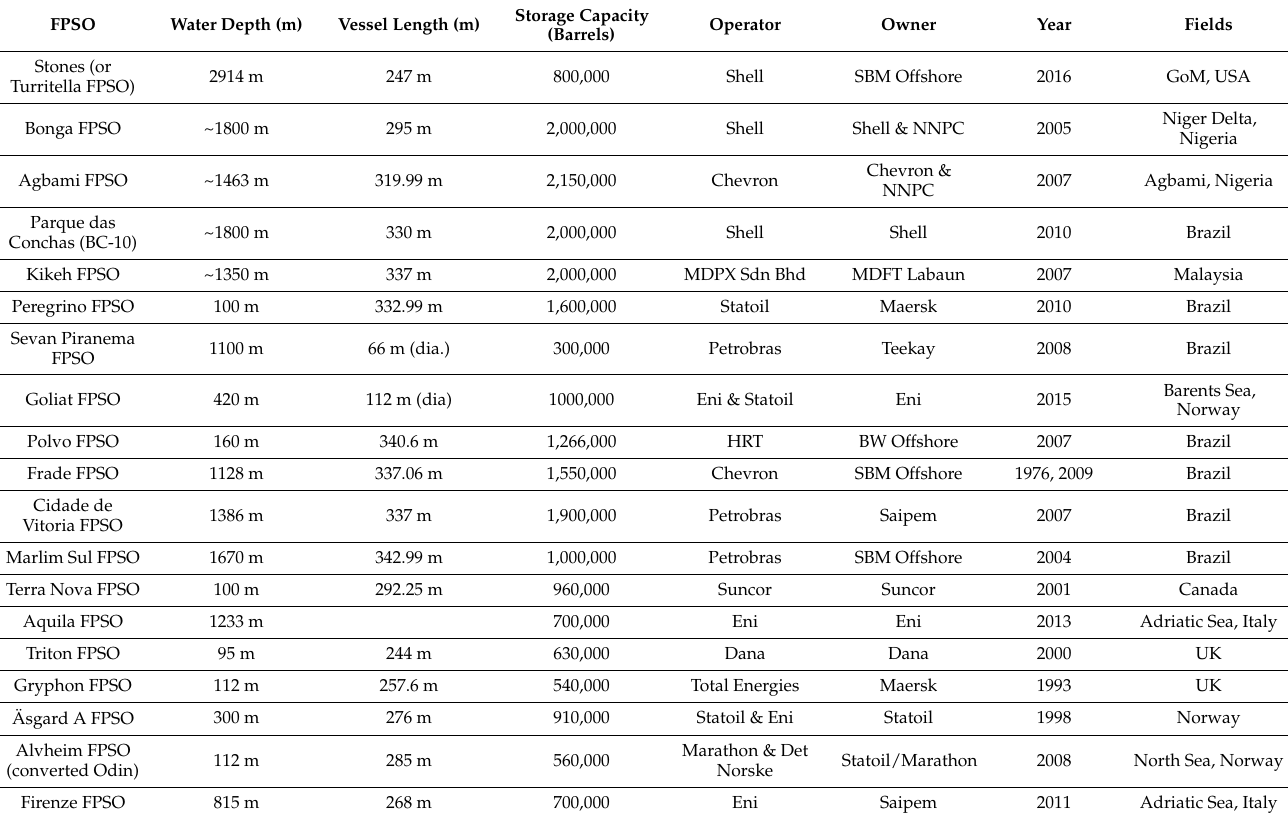
Table 11. List of some FPSOs globally used on oil and gas facilities.